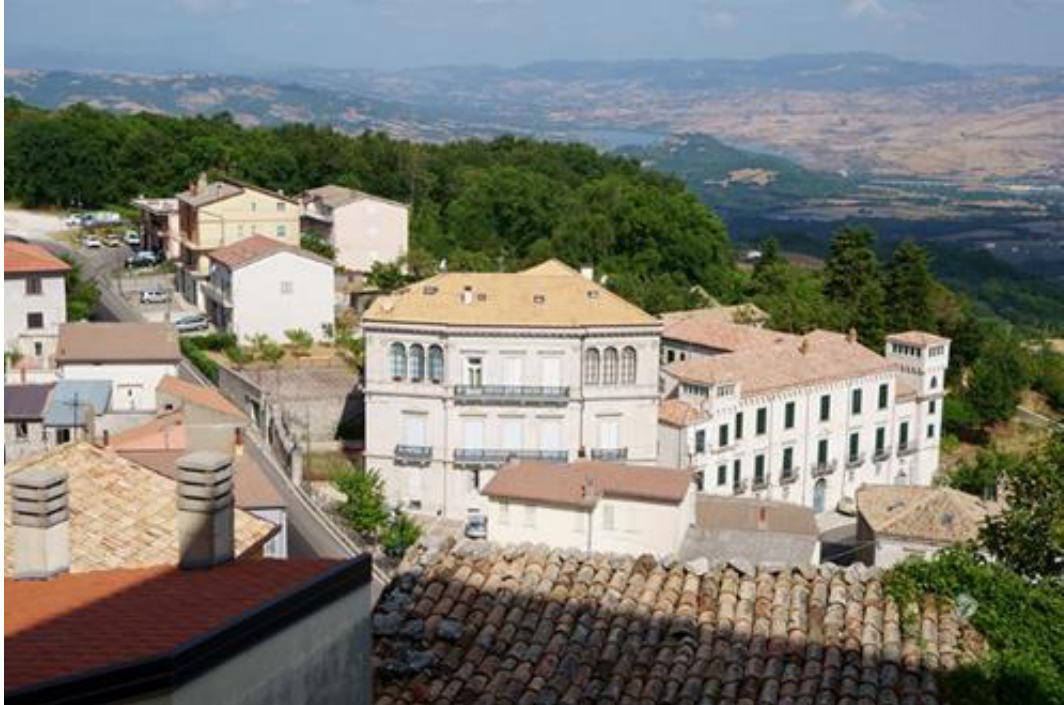
Figure 67. Pescopagano: panoramic view of a part of village (photos by [35,36]).